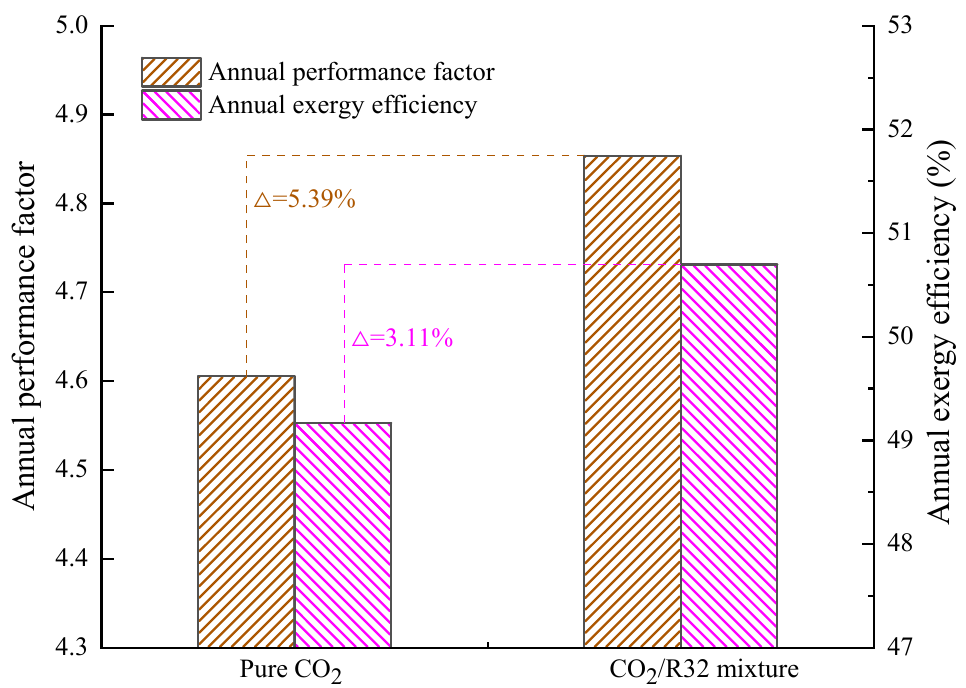
Figure 14. Comparison of the annual performance factor and annual exergy efficiency with pure CO 2 and with CO 2 /R32 mixture refrigerants.